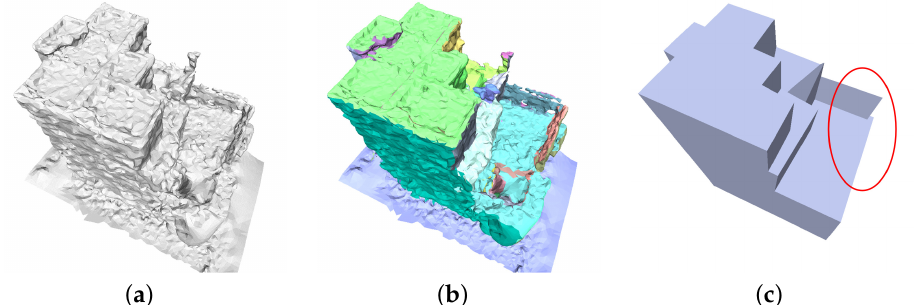
Figure 4. Results of thin-plate construction before improvement: ( a ) Original, ( b ) Segmentation, and ( c ) No correction result.